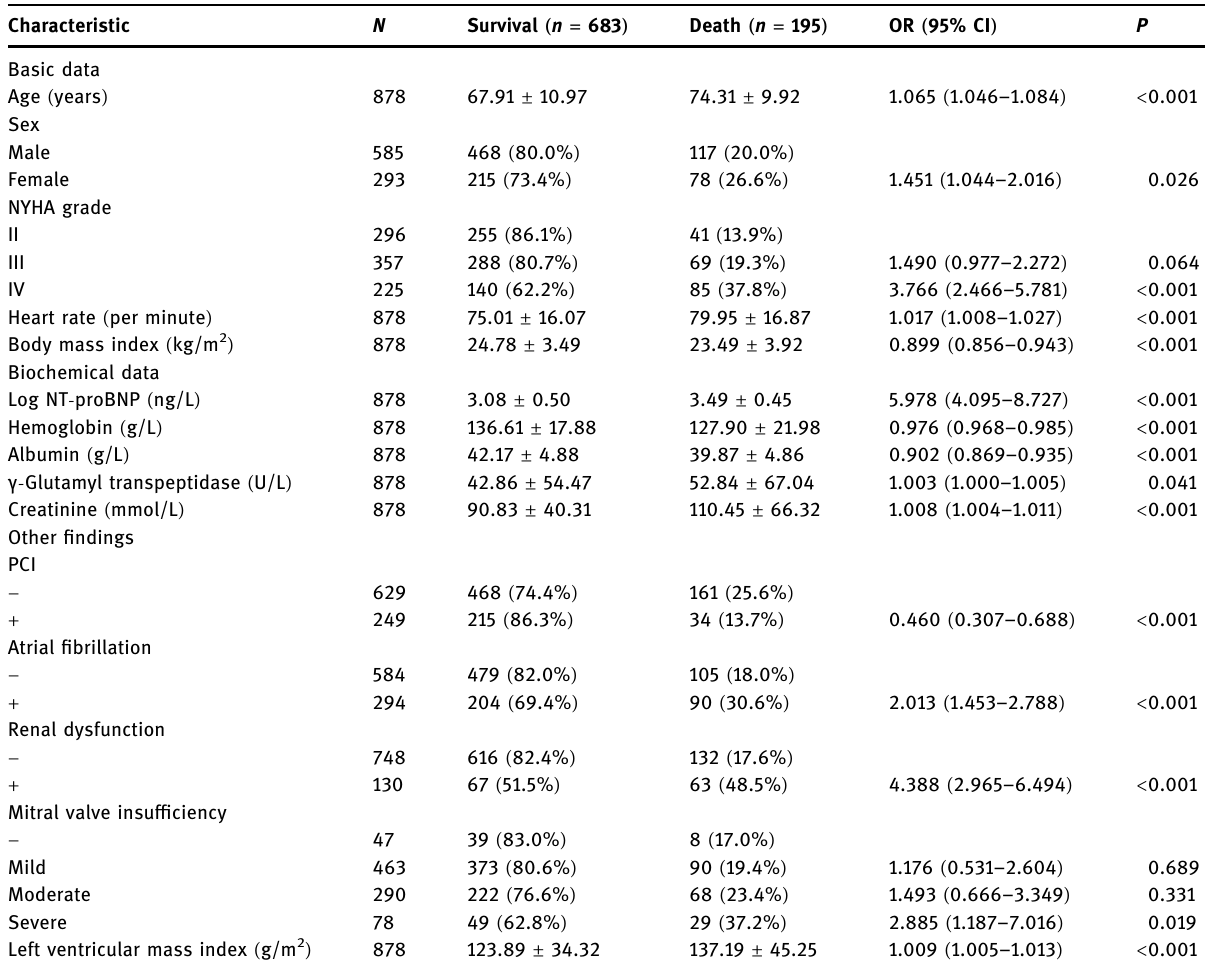
Table 1: Patients ’